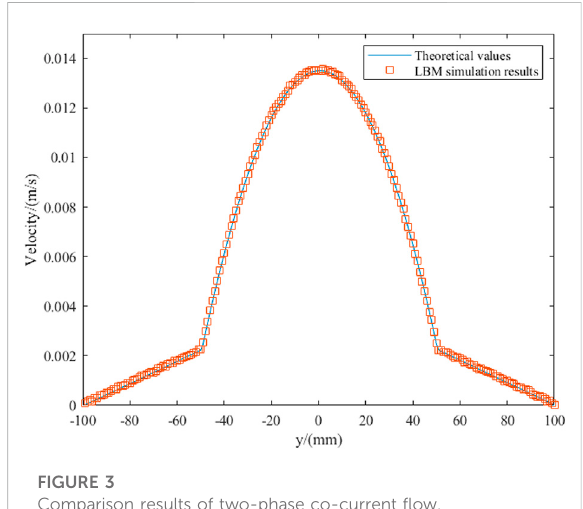
FIGURE 3 Comparison results of two-phase co-current fl